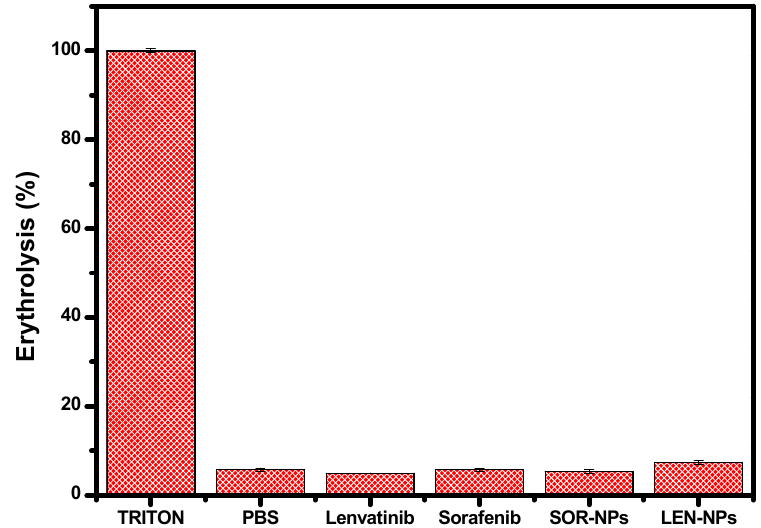
Figure 8. Erythrocompatibility studies. Erythrolysis percentages of SOR-NPs, LEN-NPs, equivalent amounts of free drugs, and PBS only, compared with Triton X-100 as a positive control.